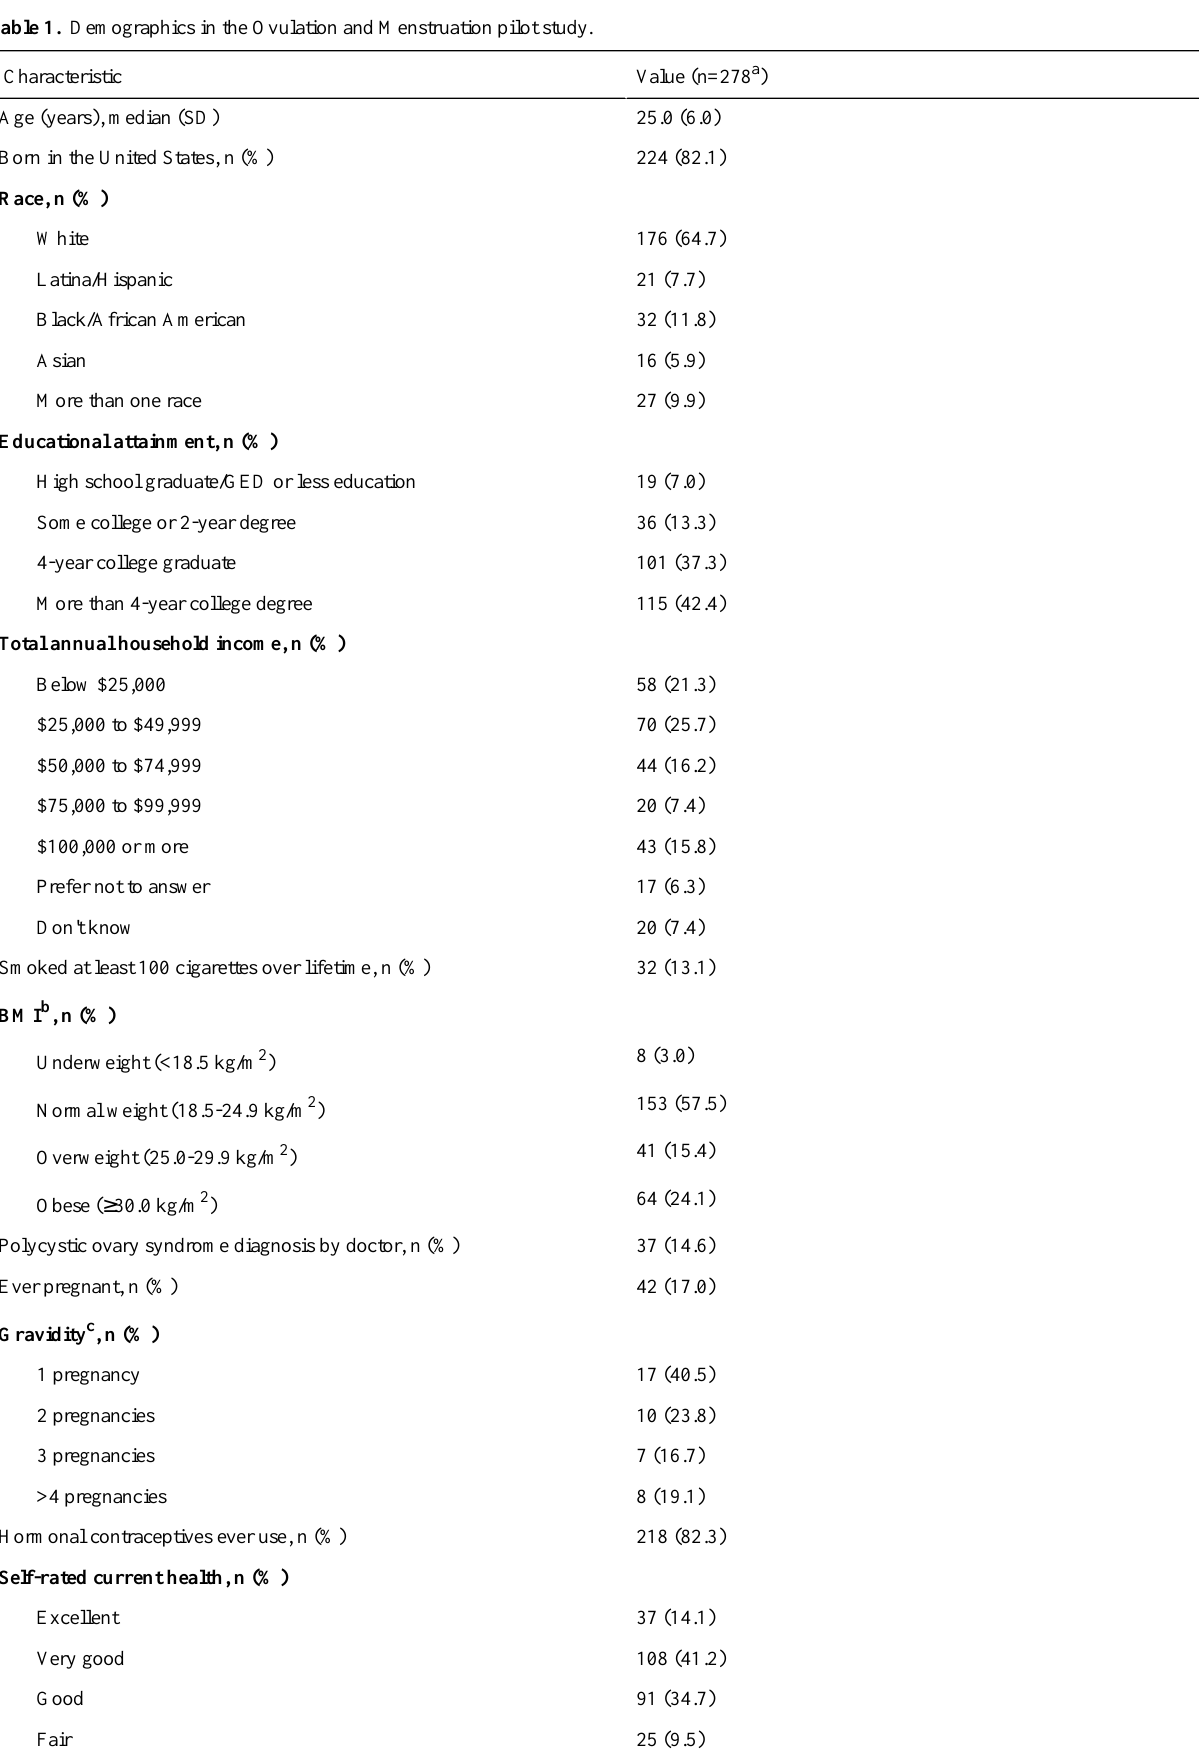
Table 1. Demographics in the Ovulation and Menstruation pilot